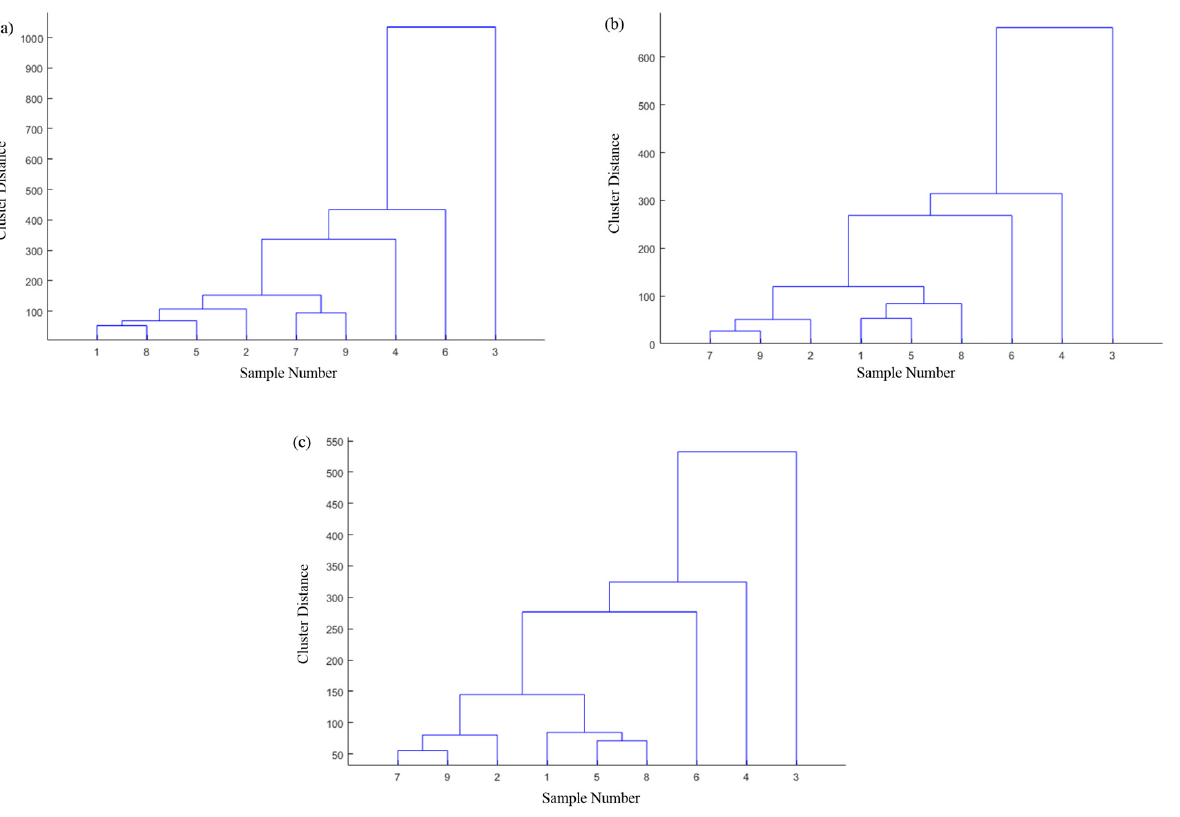
Figure 5. Clustering results for three time periods, ( a ) 7:00–9:00 (peak time), ( b ) 9:00–16:00 (off − peak time), ( c ) 16:00–19:00 (peak time).